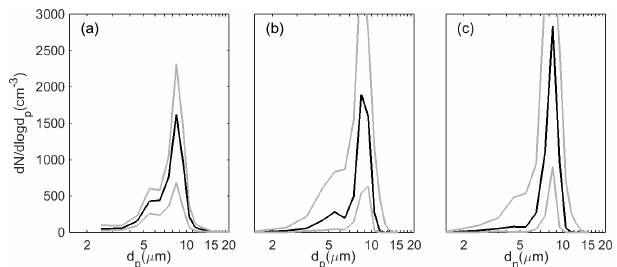
Figure 6. (a) Measured cloud droplet distribution. (b) Simulated cloud droplet size distributions using only trajectories that lead to second activation. (c) Simulated cloud droplet size distribution us- ing all trajectories. Black lines denote the ensemble median, while grey lines denote the 10th and 90th